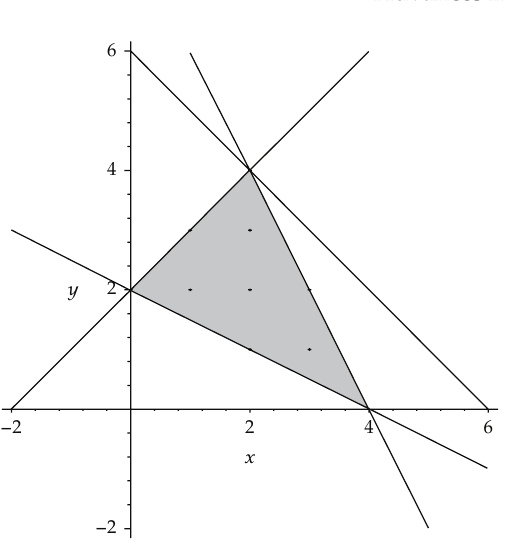
Figure 1: An example of the triangle T 2 in the case r (cid:7)